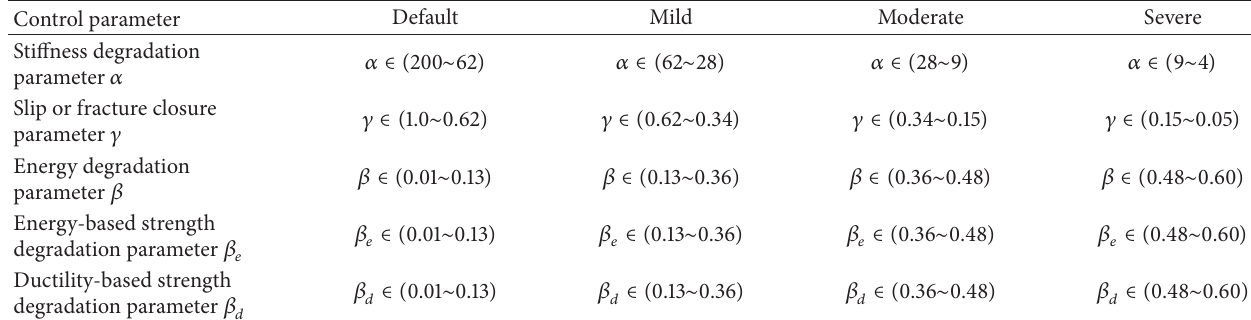
Table 9: Value ranges proposed for the five control parameters of the modified Park restoring force model. Control